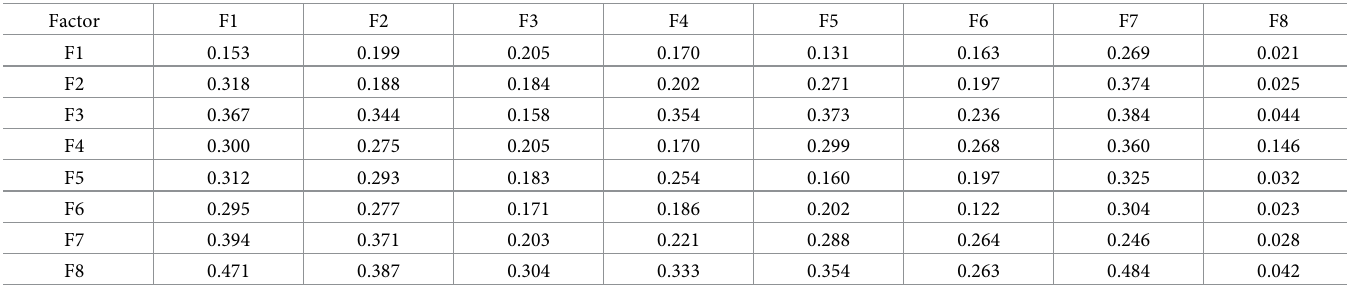
Table 4. Total—Influence matrix (T).